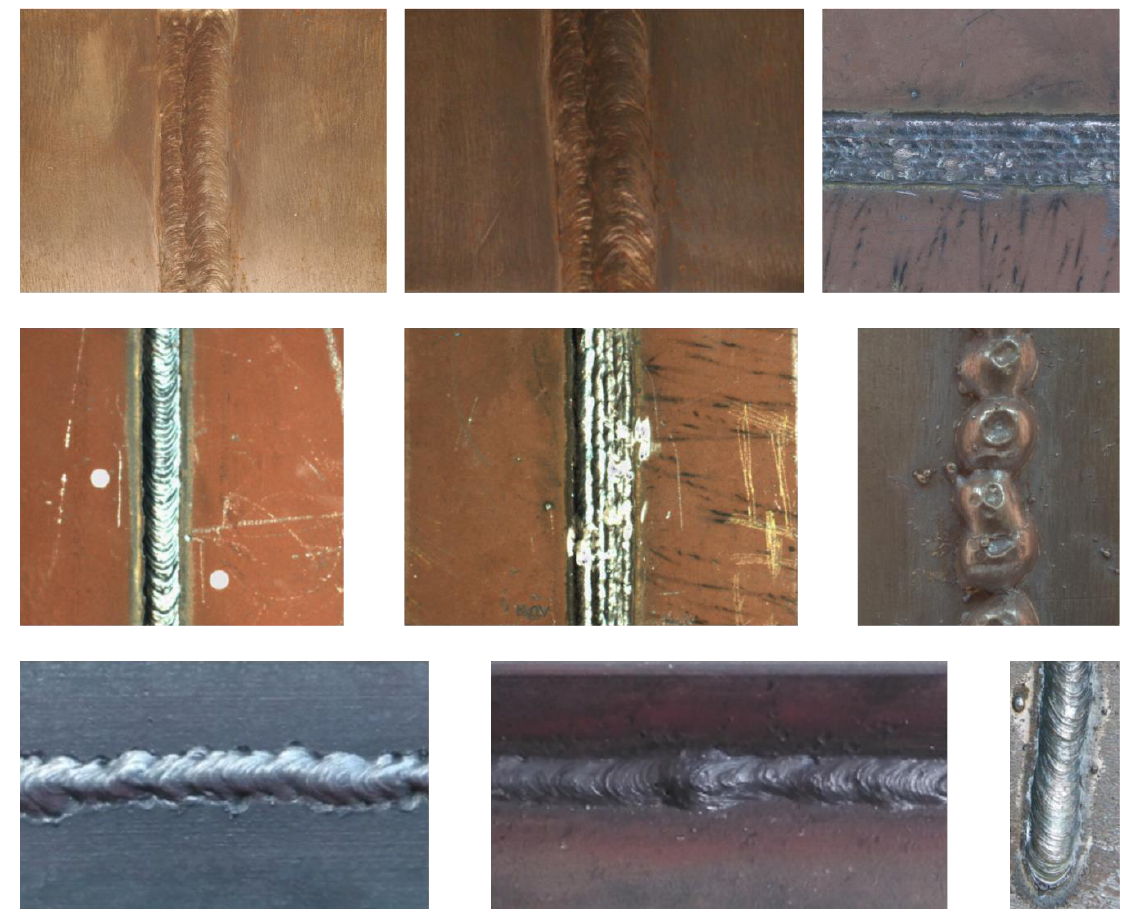
Figure 3. Different types of metallic welds acquired in real scenarios and in the laboratory.